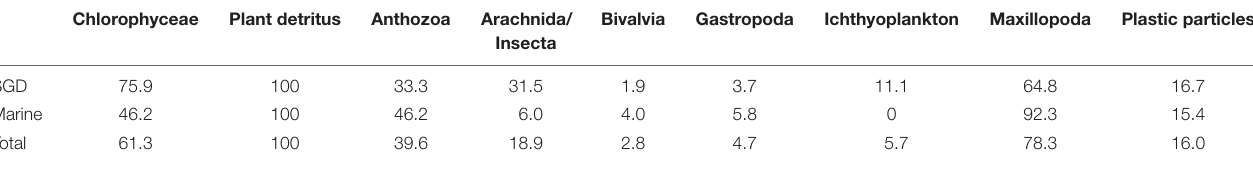
TABLE 3 | Frequency of occurrence of food organisms (to phylogenetic class level) and particles in the stomachs of Chrysiptera glauca (as percentage of all juveniles) sampled in either a tide pool influenced by fresh submarine groundwater discharge (SGD), in a strictly marine tide pool (marine), as well as in both tide pools combined